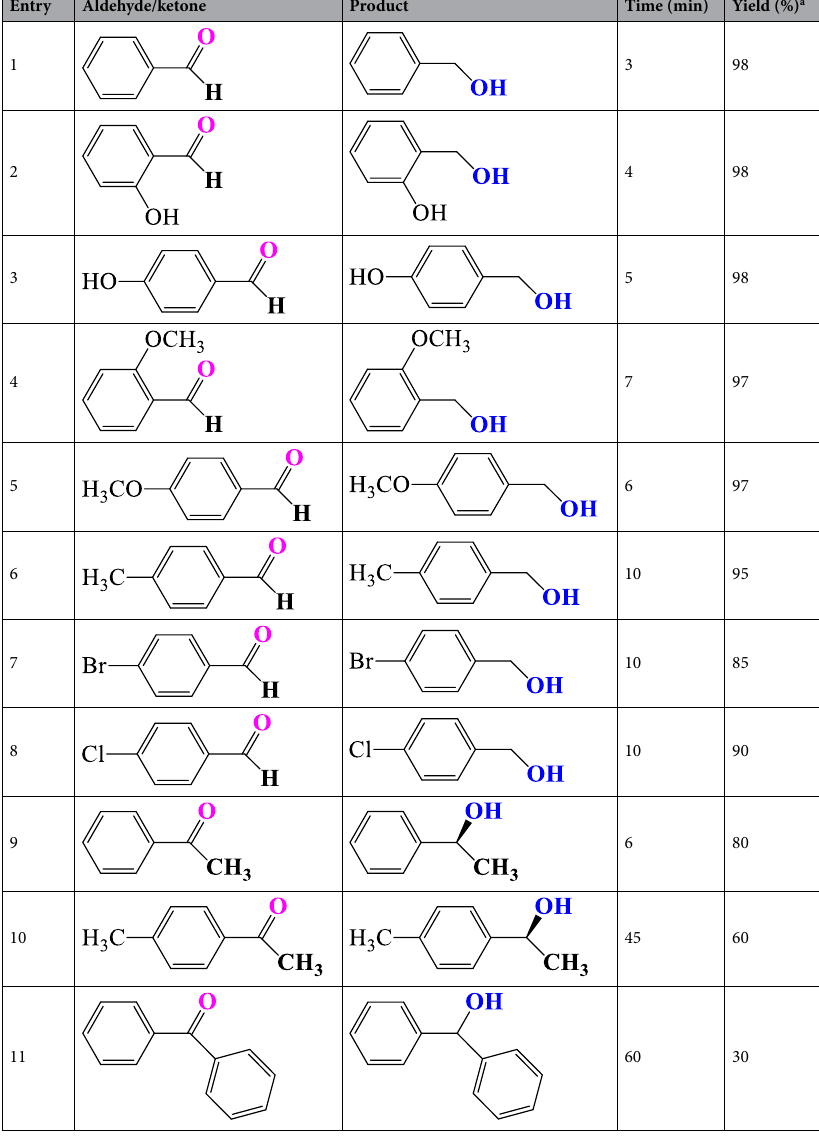
Table 2. The reduction reaction of aldehyde and ketone compounds in the presence of biochar/Fe 3 O 4 –Ag nanocatalyst. Reaction condition: aldehyde and ketone compounds (0.5 mmol), catalyst (5 mg), H 2 O (2 mL), NaBH 4 (1 mmol), RT. a Isolated